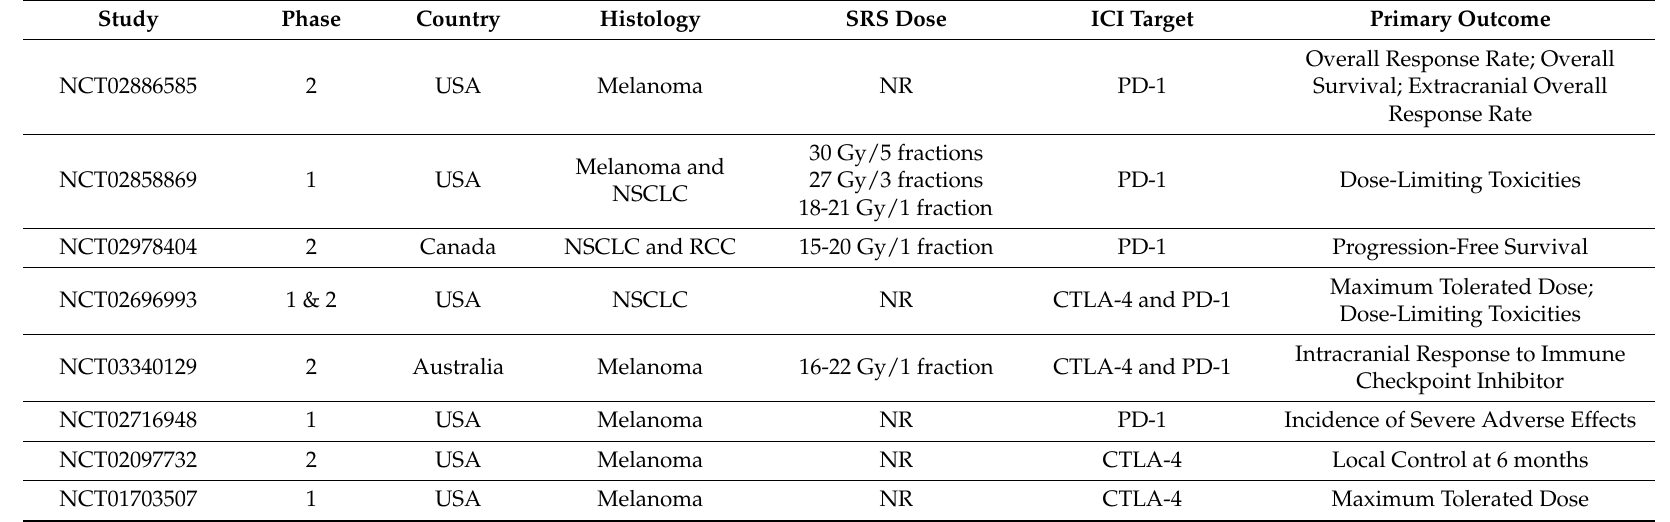
Table 3. Active and planned randomized control trials assessing the safety and efficacy of SRS and immune checkpoint inhibitors in the treatment of brain